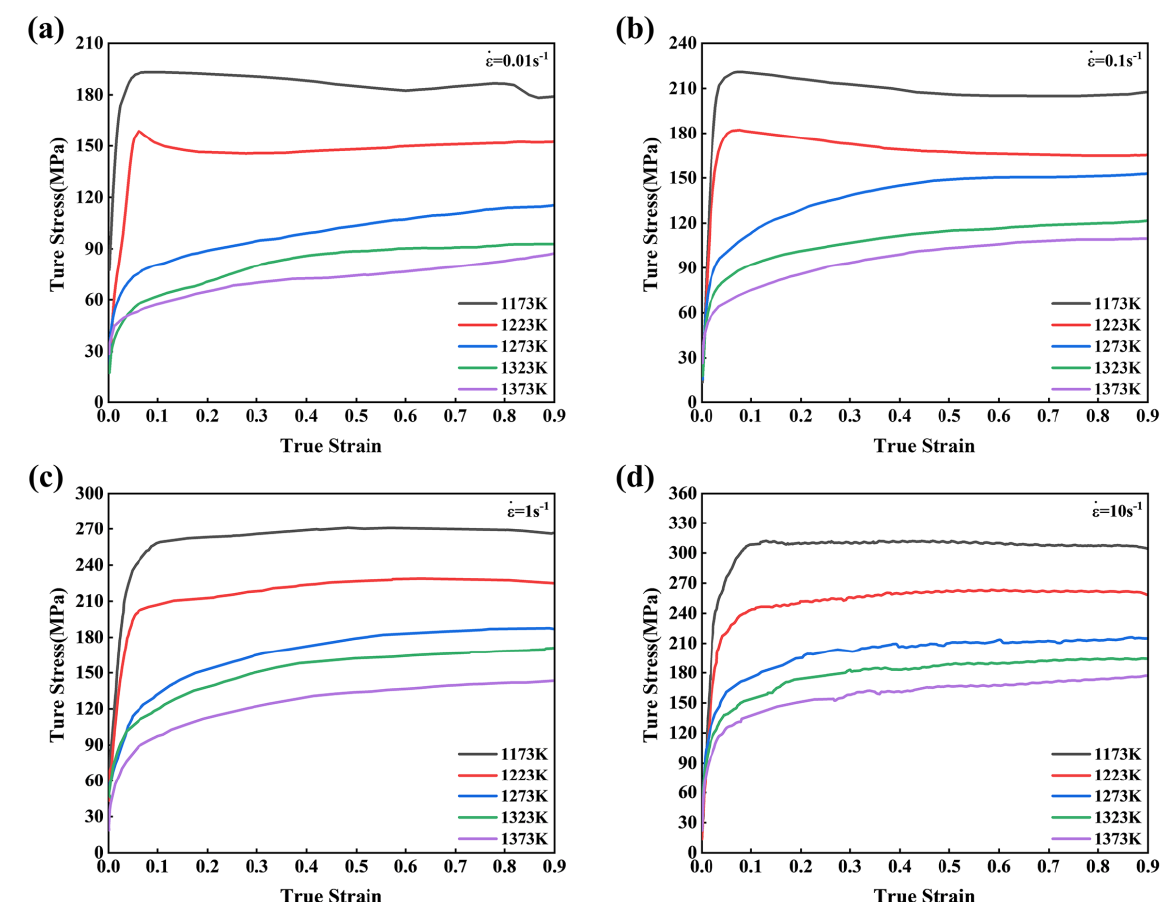
Figure 2. True stress–strain curves under the different deformation temperatures with strain rates. ( a ) 0.01 s − 1 ; ( b ) 0.1 s − 1 ; ( c ) 1 s − 1 ; ( d ) 10 s − 1 .